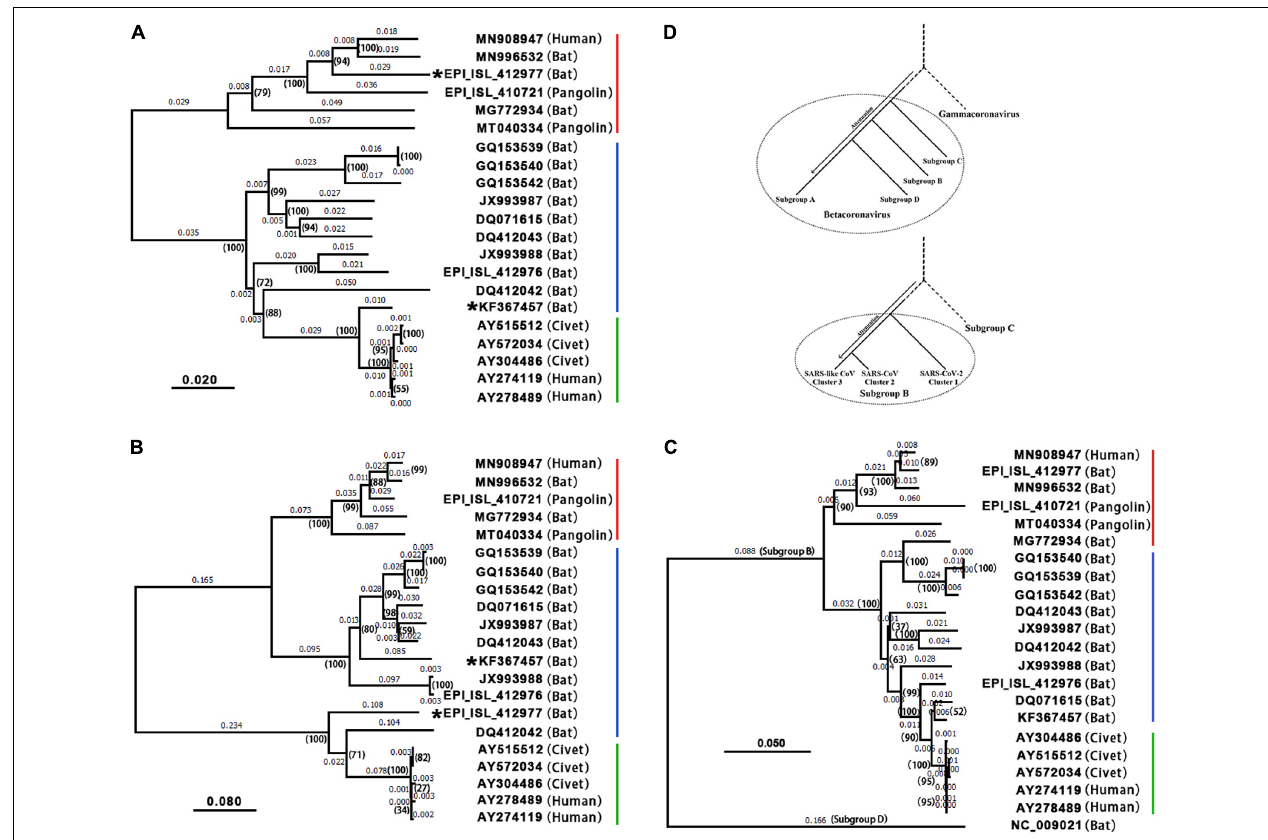
FIGURE 3 | Phylogenetic analysis and evolution of betacoronavirus. The accession numbers of the GenBank or GISAID databases were used to represent the viral genomes: MN908947: SARS-CoV-2; MN996532: the SARS2-like CoV strain RaTG13; EPI_ISL_412977: the SARS2-like CoV strain RmYN02; EPI_ISL_412976: the SARS-like CoV strain RmYN01; KF367457: the SARS-like CoV strain WIV1; AY274119: the SARS-CoV strain Tor2; AY278489: the SARS-CoV strain GD01. Decimal above the branches are phylogenetic distances calculated using the NJ method with a bootstrap test (1,000 replicates). The bootstrap values (indicated by parentheses) were in the format for displaying percentages with "%" omitted. 19 of 21 betacoronaviruses were classified into the SARS-CoV-2&SARS2-like CoV (red), SARS-like CoV (blue) and SARS-CoV (green) clusters, while the other two (i.e., WIV1 and RmYN02) are recombinant strains. (A) Phylogenetic tree 1 was built using large segments spanning S2 , ORF3a , E , M , ORF6 , 7a , 7b , N(9b) , and ORF10 ( Table 1 ). (B) Phylogenetic tree 2 was built using ORF8 . As type 2 ORF8 genes cannot be well aligned to types 1 or 3 ORF8 genes to calculate nucleotide identities, the distances between the SARS-CoV cluster and the SARS-CoV-2&SARS2-like CoV or SARS-like CoV clusters are not accurate. (C) Phylogenetic tree 3 was built using CDSs of nsp12 (RNA-dependent RNA polymerase, RdRP). HKU9-CoV (RefSeq: NC_009021) from the subgroup D was used as an outgroup strain. (D) MERS-CoV (GenBank: JX869059), SARS-CoV-2 (GenBank: MN908947), HKU9-CoV (RefSeq: NC_009021), MHV (RefSeq: NC_001846) and IBV (RefSeq: NC_001451) were used to represent betacoronavirus subgroups C, B, D, A and gammacoronavirus, respectively in the upper phylogenetic tree; SARS-CoV-2 (GenBank: MN908947), SARS-CoV (GenBank: